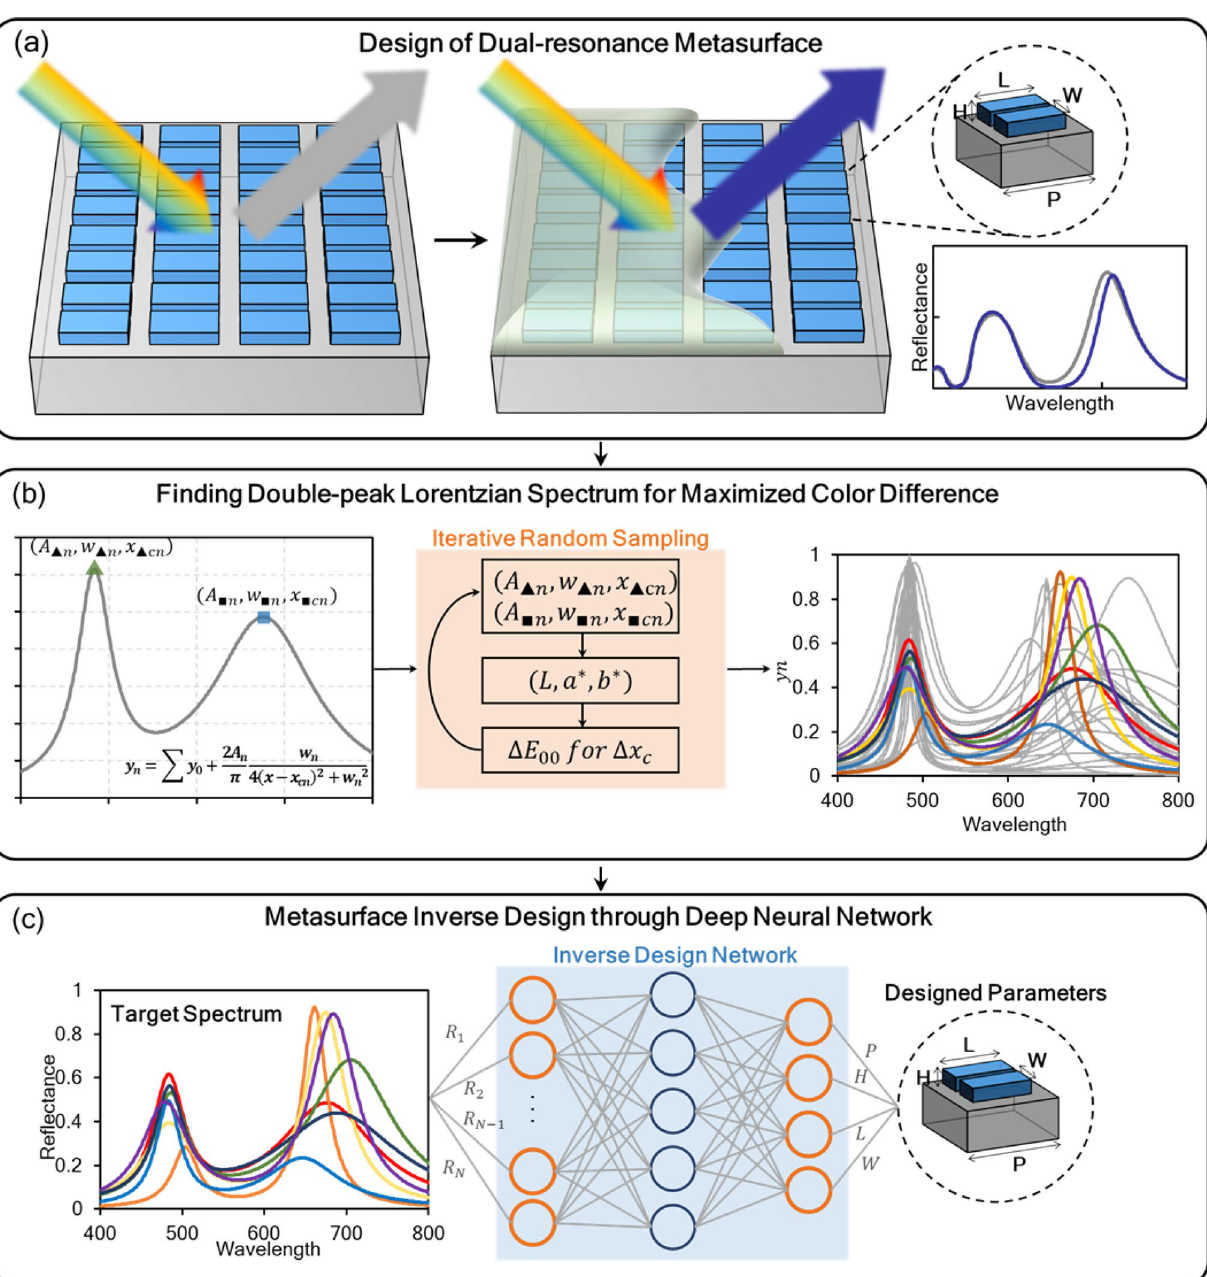
Figure 1. Overall design schematic diagram. ( a ) Design of double-bar structured metasurface introducing dual-resonance in visible wavelength and its application to colorimetric sensing. ( b ) Setting process of target spectrum through iterative random sampling of the sum of Lorentzian functions to specify the lineshape of dual-resonance. ( c ) Inverse design through deep neural network finding unit-cell parameters from the target